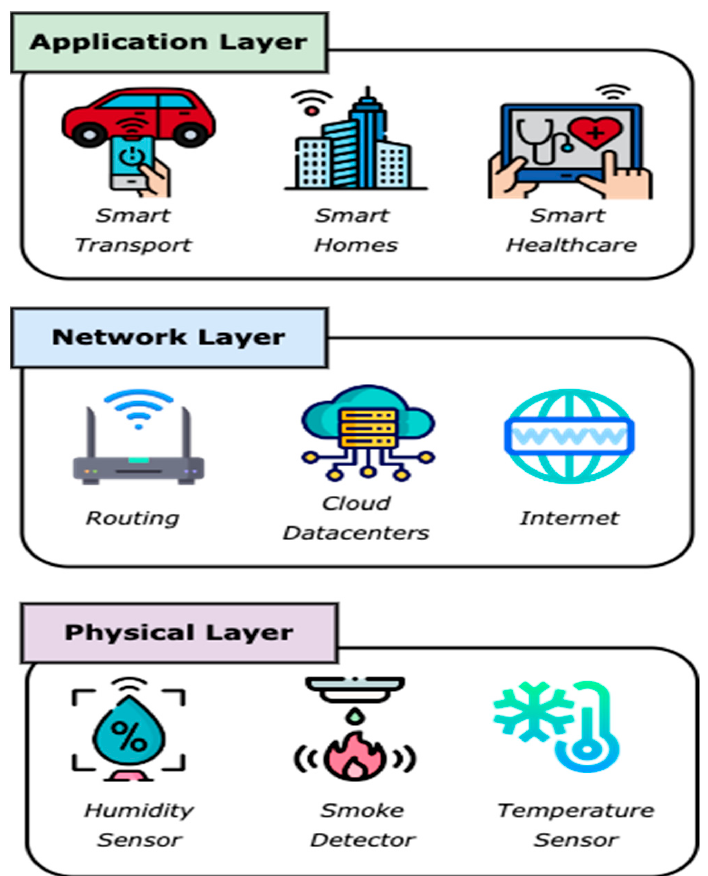
Figure 2. IoT layers classification (based on definitions from refs.) [1–3].